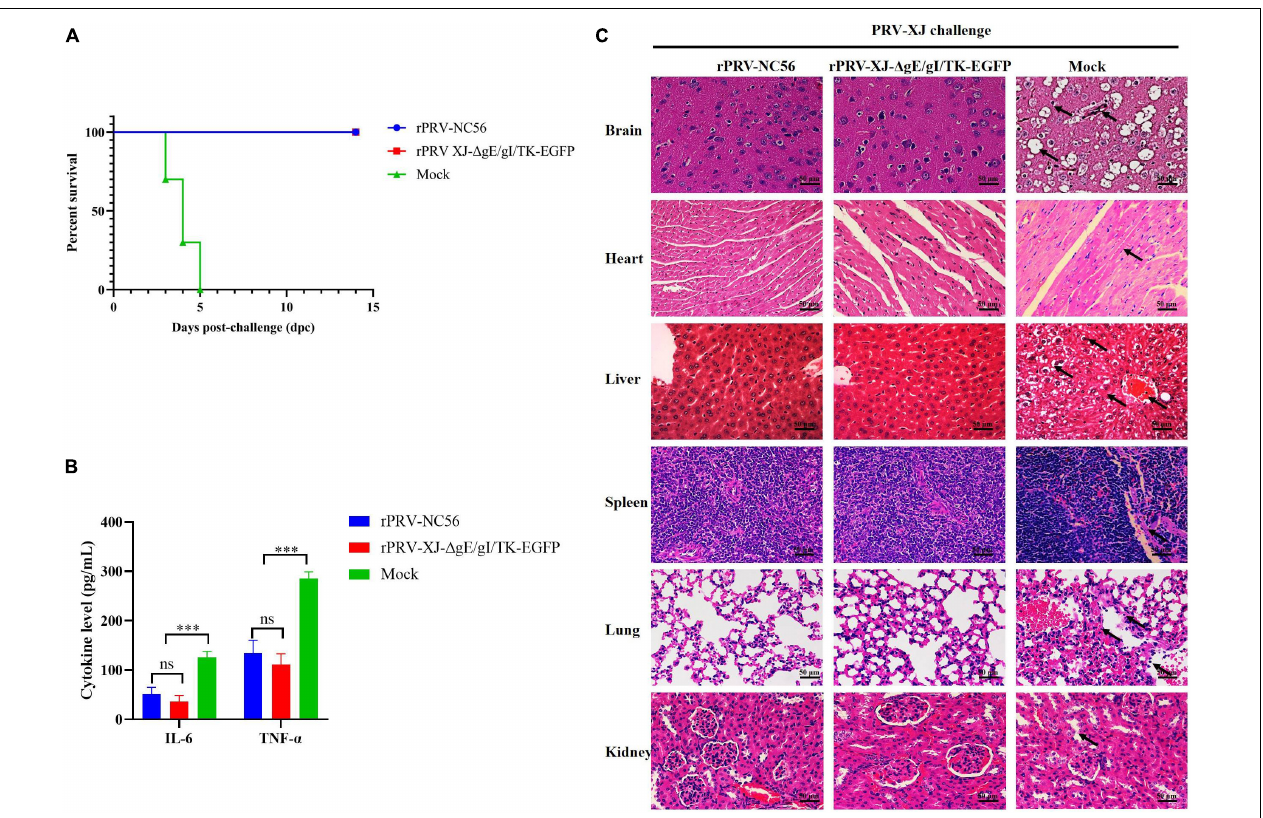
FIGURE 10 | Recombinant pseudorabies virus-NC56 has a 100% protective capacity against challenge by virulent PRV XJ. (A) The survival rate of rPRV XJ- (cid:49) gE/gI/TK-EGFP, rPRV-NC56, and nonvaccinated mice groups challenged with PRV XJ strain. (B) The results of inflammatory cytokines (IL-6 and TNF- α ) in the serum of mice in each group at 3 dpc by ELISA. (C) Histopathological examination of mice brain, heart, liver, spleen, lungs, and kidneys at 5 days postchallenge (dpc) ( × 400). ∗ p < 0.05; ∗∗ p < 0.01; ∗∗∗ p < 0.005; and ∗∗∗∗ p < 0.001. Pathological lesions in all tissues were described in the